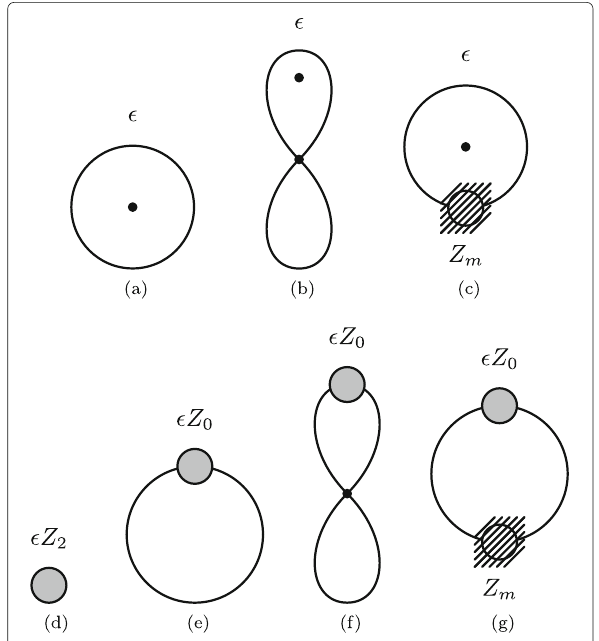
Fig. 3 Zero-point functions up to O ((cid:4)λ) . Propagators circling around the dot are the O ((cid:4)) propagators. The gray blobs denote insertions of Z 0 or Z 2 , while the shaded blobs denote insertions of Z